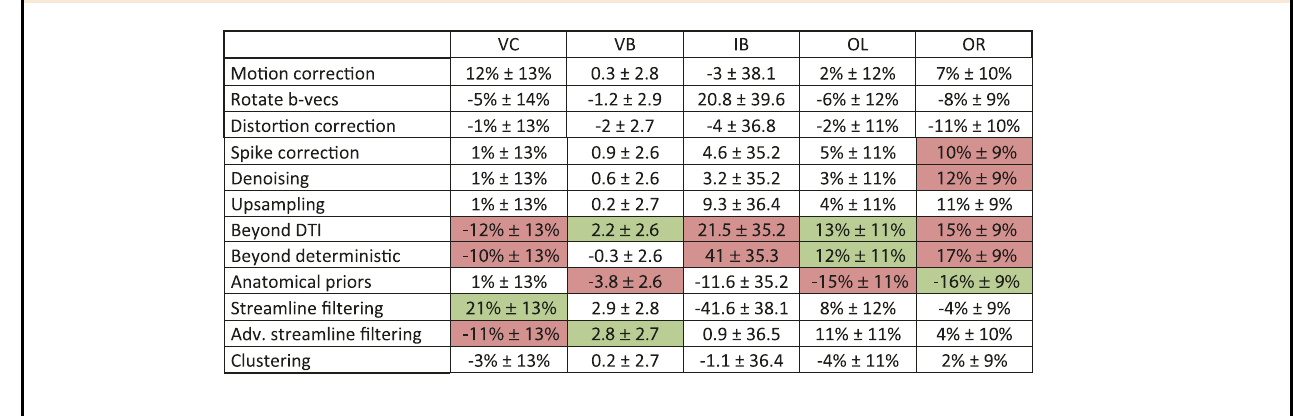
Table 1 Summary of the statistical analysis